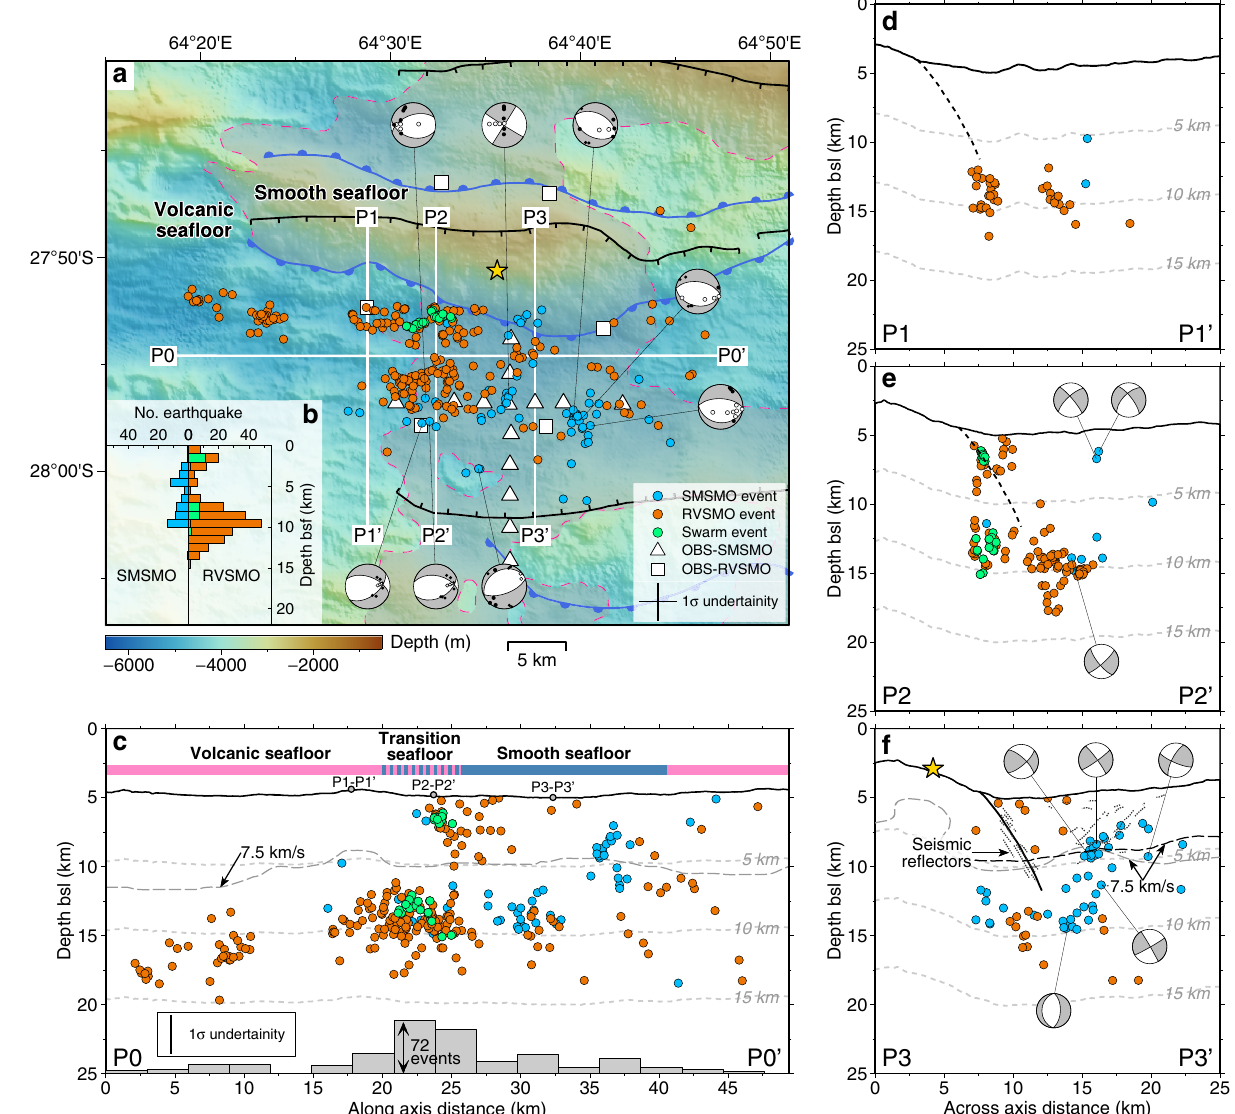
Fig.2|Distributionofearthquakesandfocalmechanisms.a Bathymetricmapof theSWIR64°30 ’ Eareashowing307eventsoftheSMSMO(bluecircles)andRVSMO (orange circles) catalogs, the RVSMO seismic swarm (green circles), and 8 deter- mined focal mechanisms. Cross in the legend shows the average absolute hor- izontal location uncertainty of 3.2km (1 σ ). Geological information (see legend for symbols) includes breakaways, emergences, and the boundary between volcanic andsmoothsea fl oor 1 .Best- fi ttingfocalmechanismshaveclearupward(blackdots) and downward (white dots) fi rst motions of P-wave onsets (see the “ Methods ” section). Depth pro fi les (P0 – P0 ’ to P3 – P3 ’ ) are marked as labeled white lines in a . b Histograms of earthquake depths below the sea fl oor for the SMSMO (blue) and RVSMO(orange)catalogs, including theseismicswarm(green). c Along-axisdepth pro fi le P0 – P0 ’ projecting earthquakes within ±8km off the pro fi le (VE=1 and the